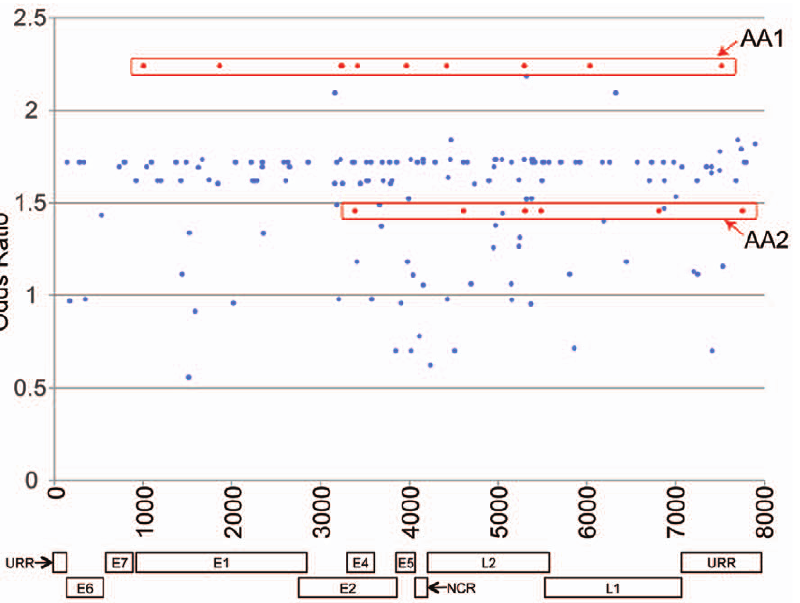
Figure 4. HPV16 viral genome-wide association study (VWAS). Odds ratios for an outcome of CIN3 + vs. resolved HPV16 infections were calculated for every SNP that occurred . 10 times in the imputed and determined nucleotide sequences for 412 HPV16 positive samples from the Guanacaste, Costa Rica cohort [10]. Odds ratios for each SNP are plotted against their position in the genome. Some stratification of SNPs by odds ratio is evident. By mapping the bands of SNPs back to the lineage-specific SNP plot, it was possible to determine that the band with the highest odds ratio was composed of SNPs from the AA1 sublineage. For comparison, red boxes indicate the bands containing AA1- and AA2-specific SNPs. Due to statistical power limitations in this study, none of the SNPs attained viral genome-wide significance. Despite this, the plot suggests differences in disease association between sublineages.